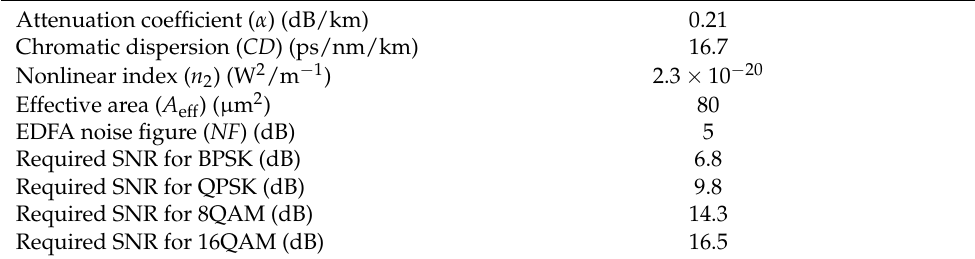
Table 3. Transmission system